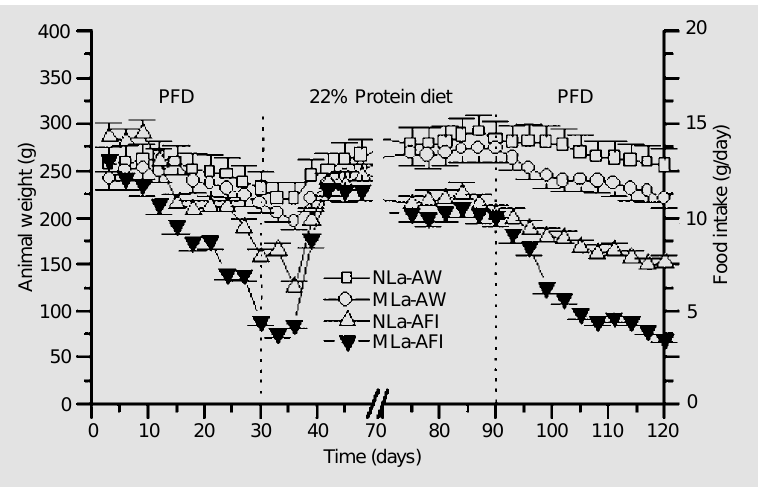
Figure 1. Animal weight (AW) and food intake (AFI) of one-year-old offspring from dams normally nourished (NLa-AW and NLa-AFI) or dams malnourished during the first 10 days of lactation on a protein-free diet (PFD) during two periods of 30 days (MLa-AW and